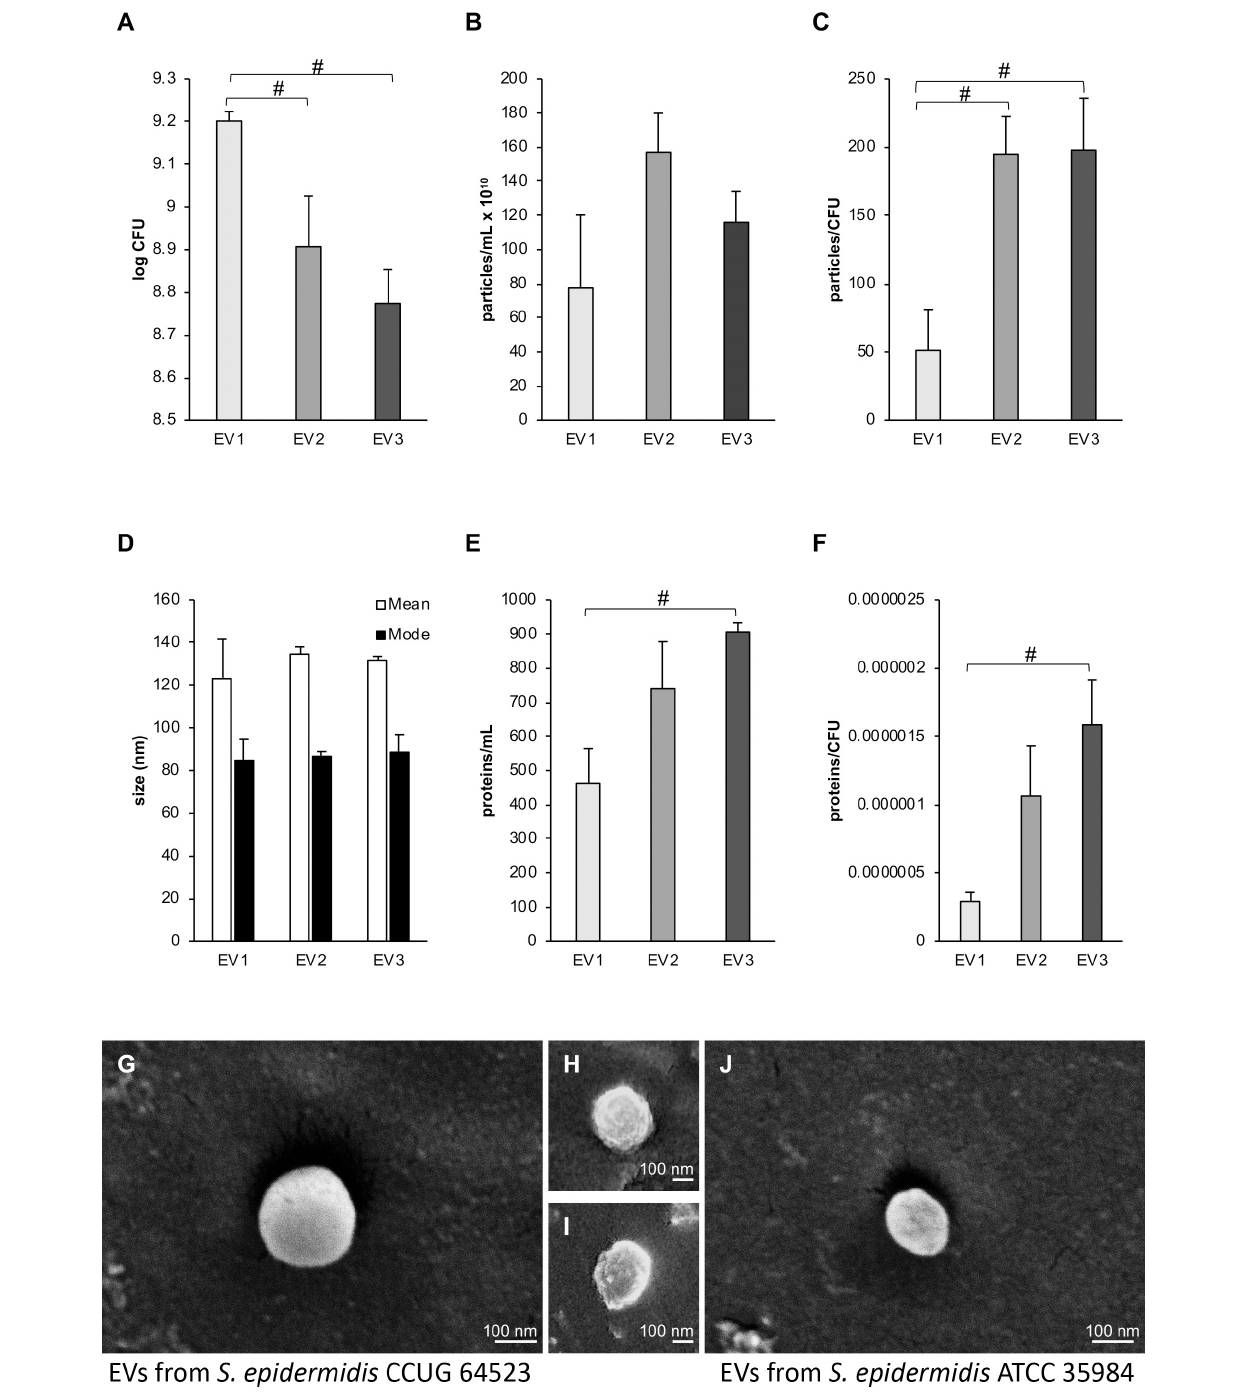
FIGURE 2 | Influence of subinhibitory culture conditions on vesiculation. (A) CFUs per mL of Staphylococcus epidermidis CCUG 64523 cultures supplemented with different gentamicin concentrations used for EV isolation. (B) Particles per mL for the different EV isolation conditions as determined by NTA. (C) Particles per CFU. (D) The mean and mode sizes of particles as determined by NTA. (E) The protein levels for each EV type in µ g × mL − 1 , demonstrating significantly higher protein levels in EV 3 than in EV 1 ( p < 0.05). (F) Protein ( µ g × mL − 1 ) per CFU, and significantly higher amounts of proteins per CFU were observed in EV 3 than in EV 1 ( p < 0.05). EV 1 , EV 2 , and EV 3 , are EVs isolated in the presence of 0, 0.03, and 0.06 µ g × mL − 1 gentamycin, respectively. EVs were isolated in triplicate for each EV type, and the bars represent the mean ± SEM; # indicates a significant difference between different groups of EVs. (G–I) Representative scanning electron micrographs of EVs from S. epidermidis CCUG 64523 isolated in the presence of (G) 0, (H) 0.03, and (I) 0.06 µ g × mL − 1 gentamycin. (J) EVs isolated from S. epidermidis ATCC 35984 cultured in tryptic soy broth.